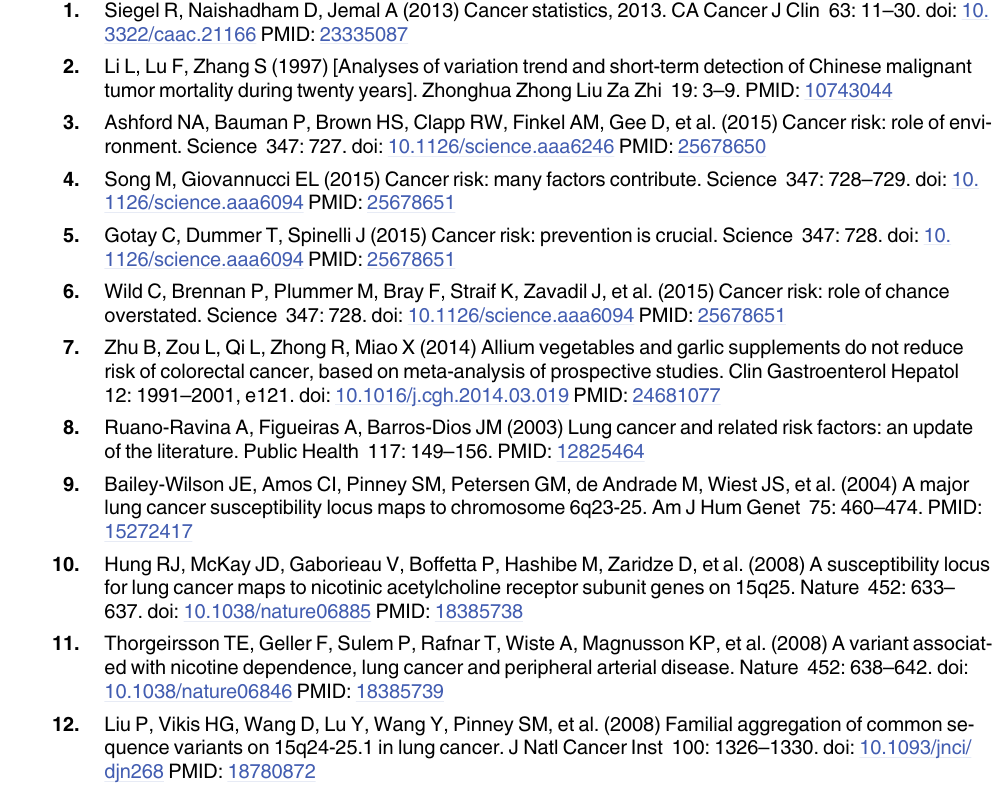
S1 Fig. Flow chart of study selection. S2 Fig. The forest plots of sensitivity analysis under dominant model. S1 Table. PRISMA Checklist. S2 Table. The association between rs931794 and risk of lung cancer by smoking status, me- dian age, age range and sex. S3 Table. Quality assessment of included studies. S4 Table. Egger ’ s test and Nonparametric trim and fill analysis of publication bias in meta-